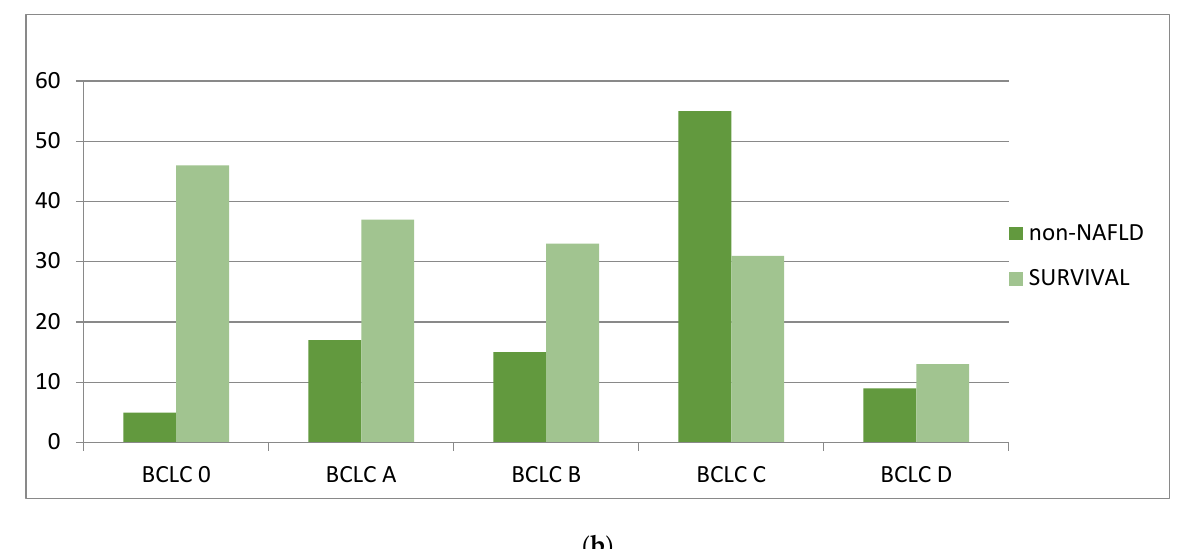
Figure 3. Comparison of the BCLC stage and survival for the ( a ) NAFLD cohort and ( b ) non ‐ NAFLD cohort. Table 4. Survival characteristics of patients with NAFLD ‐ HCC and non ‐ NAFLD ‐ HCC. NAFLD Non ‐ NAFLD p ‐ Value